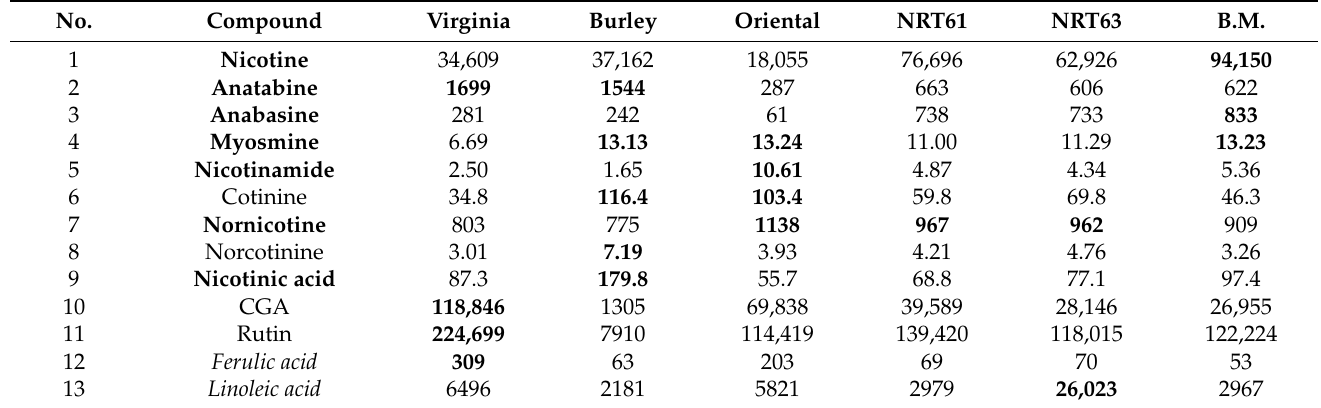
Table 5. Selected compound profiling in different N. tabacum (Virginia, Burley, Oriental) and N.